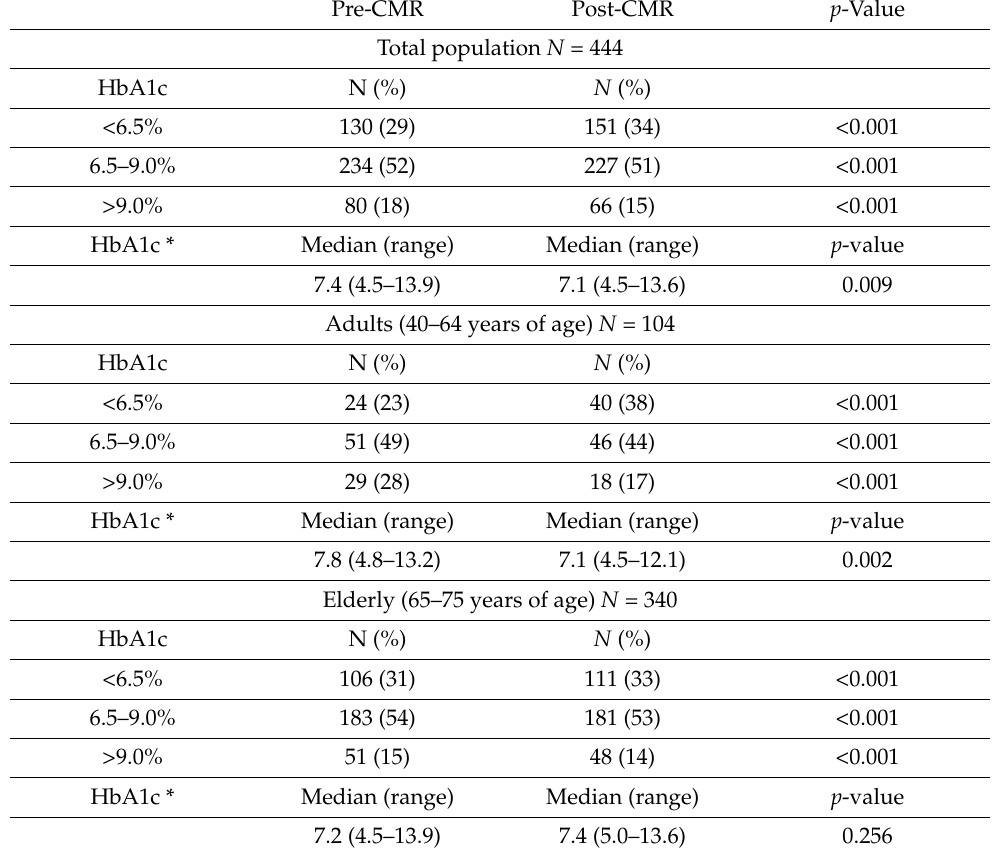
Table 2. Comparison of HbA1c values pre-comprehensive medication review (CMR) intervention and post-CMR